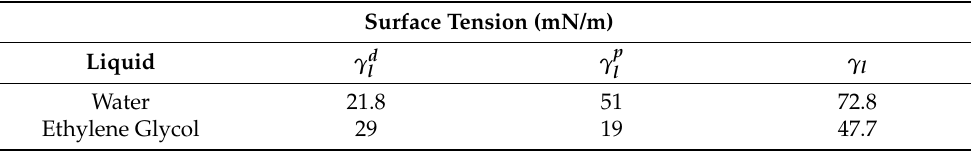
Table 1. Surface tension parameters of water and ethylene glycol.